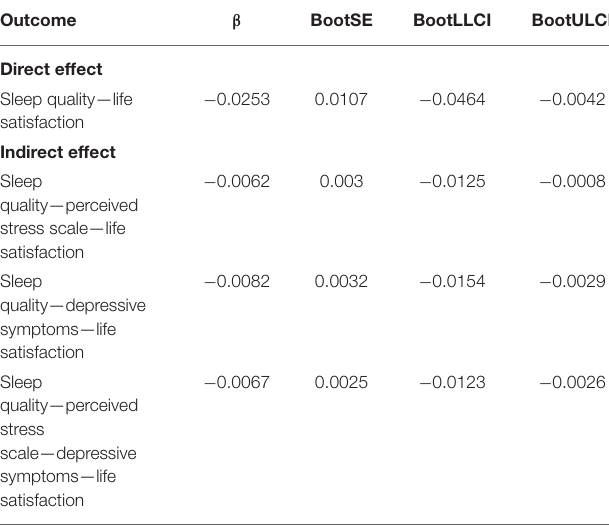
TABLE 3 | Direct and indirect effects of sleep quality on life